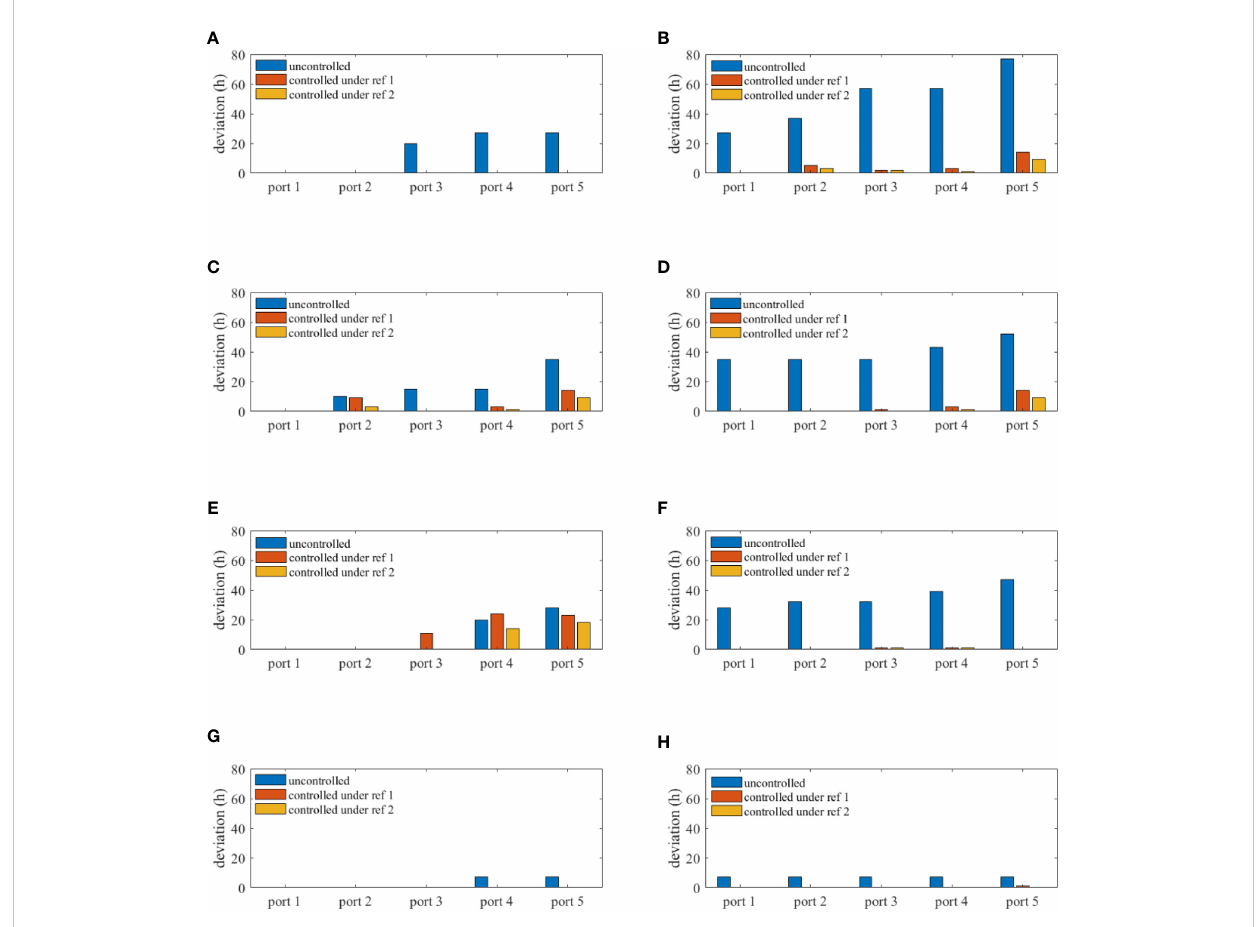
FIGURE 10 Arrival time deviations under different control methods at each port of: (A) ship 1 in the fi rst voyage; (B) ship 1 in the second voyage; (C) ship 2 in the fi rst voyage; (D) ship 2 in the second voyage; (E) ship 3 in the fi rst voyage; (F) ship 3 in the second voyage; (G) ship 4 in the fi rst voyage; (H) ship 4 in the second